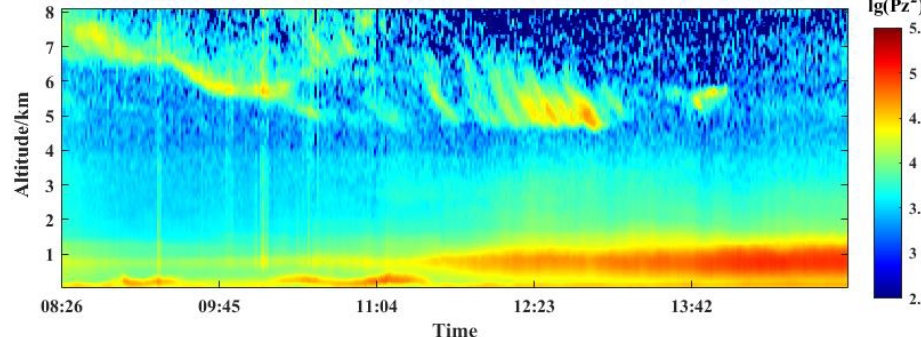
Figure 17. MPL measurement results of Funing ground station on 18 March.